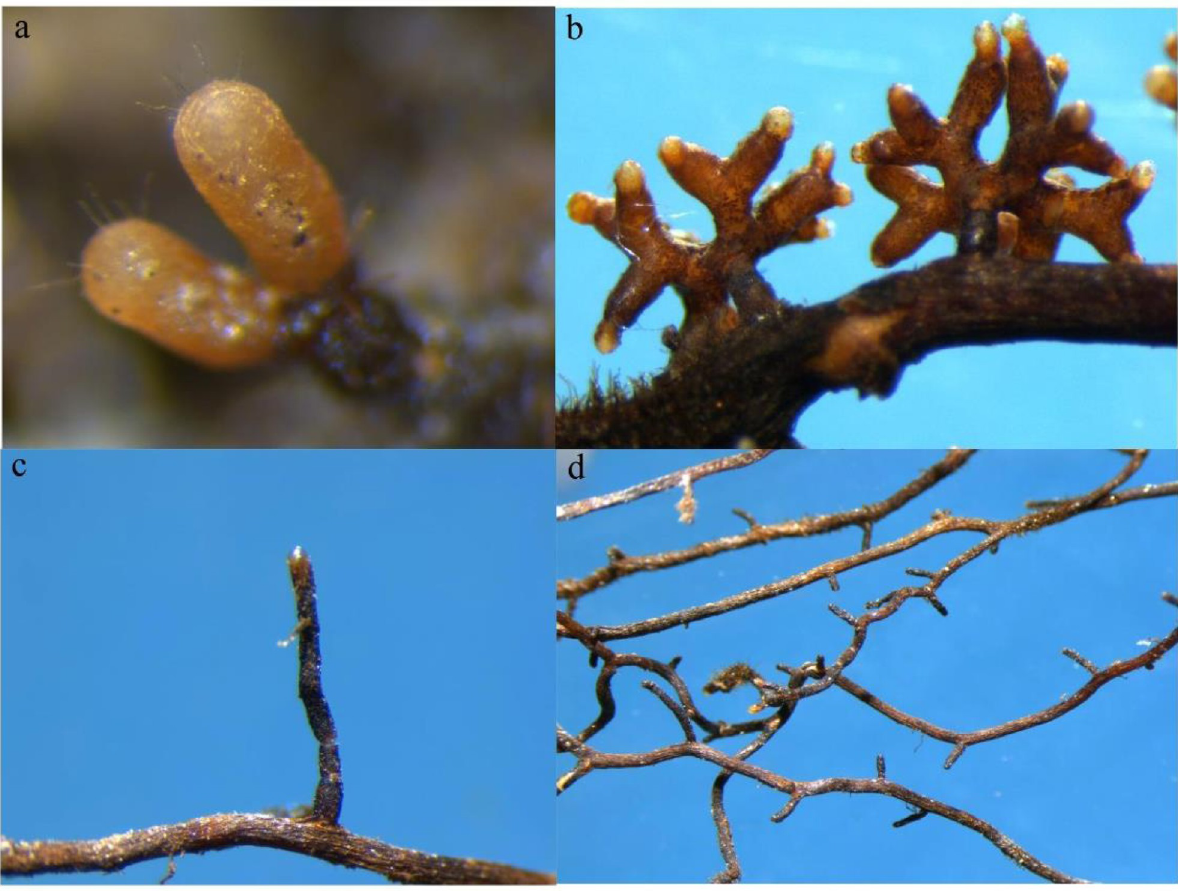
Fig 1. Root tips of Pinus armandii in association with Tuber indicum (a and b) or without T . indicum (c and d).